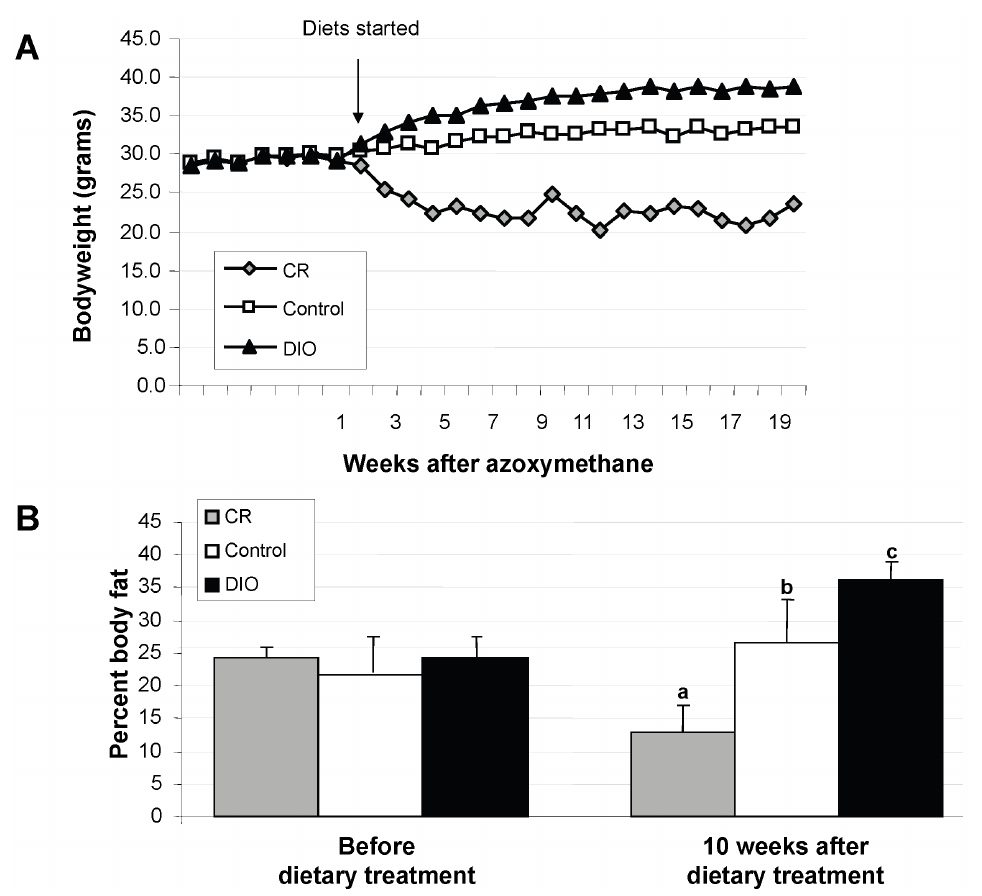
Figure 1. A. Bodyweights in calorie restricted (CR), control, and diet-induced obesity (DIO) FVB mice. Bodyweight was measured weekly in all three dietary interventions. Each data point represents the mean of all the mice in that dietary group. B. Body fat in CR, control, and DIO dietary treatments. Dual-energy X-ray absorptiometer (DEXA) scans were conducted at the beginning of the study and after ten weeks of dietary treatment. Each bar represents the mean of ten mice per group. One-way analysis of variance (ANOVA) at the beginning of the study, p=0.78. One-way ANOVA at ten weeks, p , 0.001. a , b , and c represent dietary treatments that are significantly different from one another (p , 0.05) as determined by Bonferroni